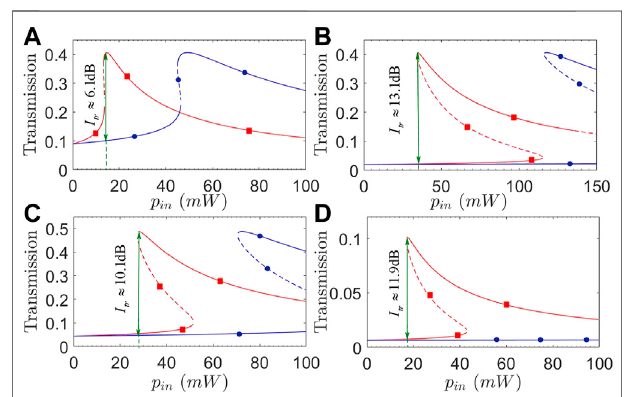
FIGURE 4 | (Color online) Transmission coef fi cients T 31 (red squares) and T 13 (bluecircles) against inputpower p in with (A) Δ 1 /2 π (cid:1) 3.5 GHz; (B) Δ 1 / 2 π (cid:1) 5.5 GHz; (C) Δ 3 /2 π (cid:1) 0.1 GHz; (D) Δ 3 /2 π (cid:1) 6.0 GHz. Solid and dashed parts of each curve refer to stable and unstable regions, respectively. Other parameters are the same as in Figure 2 , except J 23 /2 π (cid:1) 1.0 GHz.